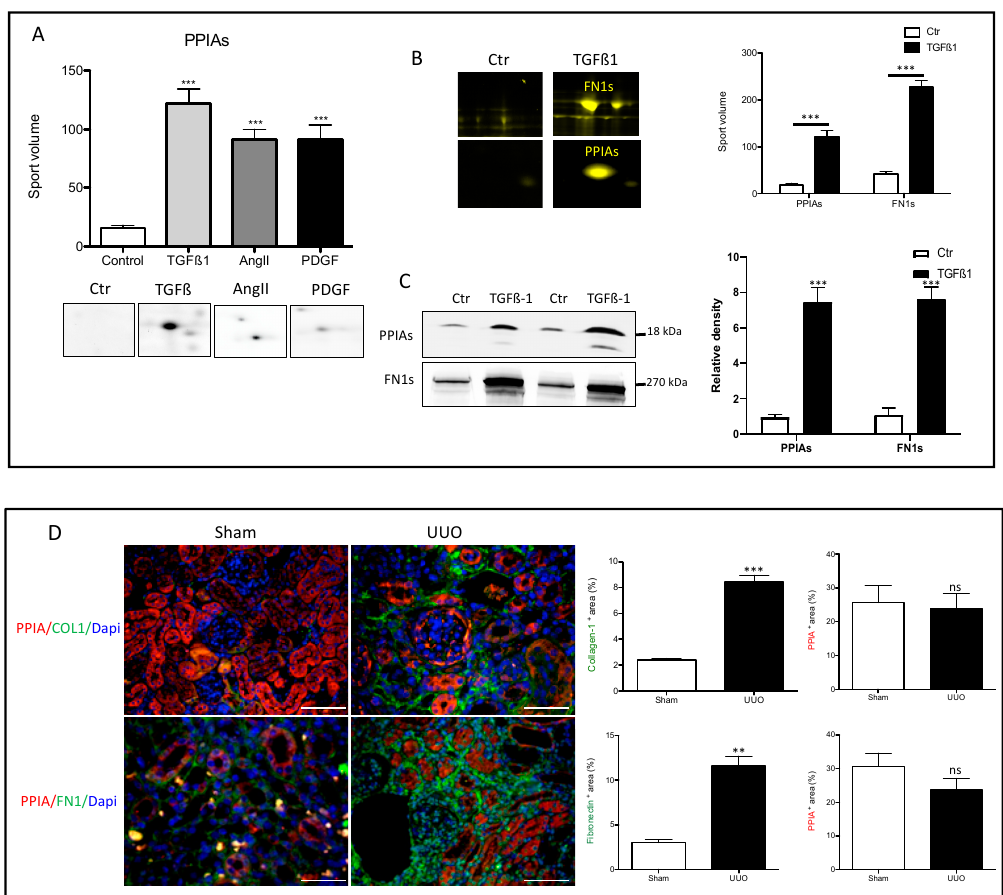
Figure 2. High secretion levels of peptidyl-prolyl cis-trans isomerase A (PPIA) and fibronectin (FN1) in stimulated renal fibroblasts cell lines. ( A ) Two-dimensional gel electrophoresis separation and quantification of PPIA secretion under different treatments. Spot volume quantification of PPIA under the three different treatments and control. The protein quantification in secretome is given in the form of bar diagrams. Results are given as the mean ± SD of the percentage volume of spot as quantified by two-dimensional gel electrophoresis (2-DE) software. PPIA showed significant differences in secretion level between the three different treatments and the control ( p < 0.05). ( B ) 2-DE quantification of PPIA and FN1 secretion level in TGF β 1-treated renal fibroblasts. ( C ) Western blot analysis and quantification of the PPIA and FN1 level in secretome of the control and TGF β 1-treated renal fibroblasts cell lines. ( D ) Mice were challenged with unilateral ureteral obstruction (UUO). Kidney sections from UUO and sham were stained with antibodies against PPIA combined either with COL1 or FN1. Area positive for PPIA, or COL1 or FN1 was assessed. Data are presented as mean ± SD. ** p < 0.01, *** p < 0.001. Scale bar: 50 μ m